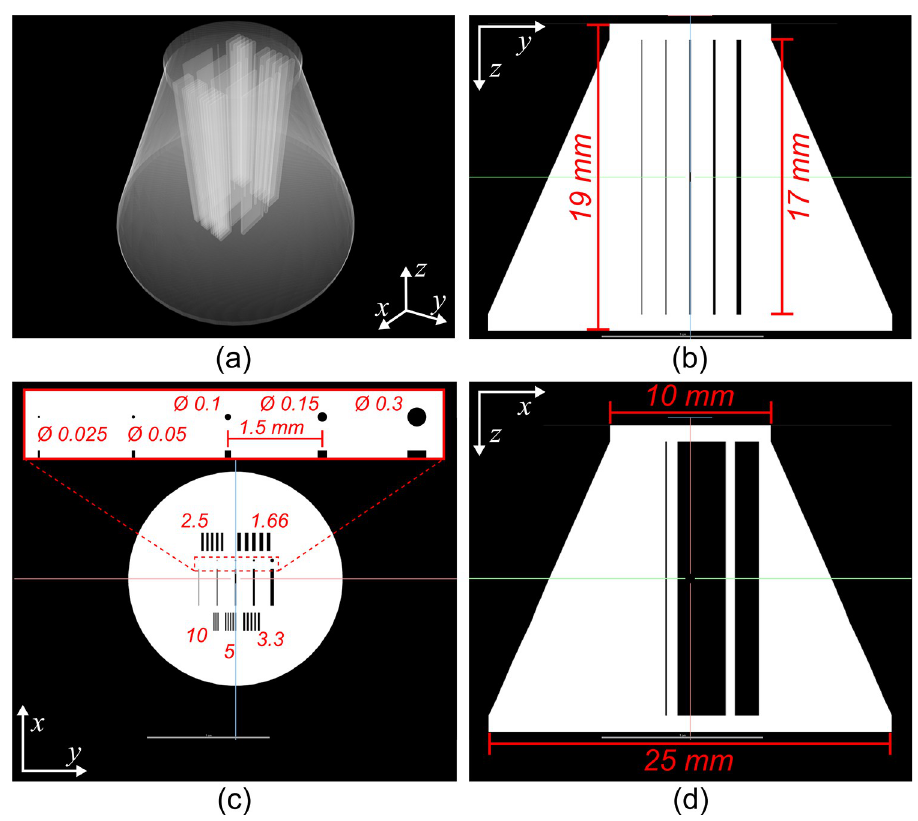
Fig 7. Computer-aided design (CAD) of the resolution titanium-alloy (Ti6Al4V) phantom. (a) translucent perspective view of 3D rendering of the phantom’s CAD. (b) Trans-coronal synthetic slice of the phantom’s CAD. (c) Trans-sagittal synthetic slice of the phantom’s CAD depicting details of the internal voids. The bar patterns are described in lp mm -1 all the other nominal measurements are shown in mm (d) Transaxial synthetic slice of the phantom’s CAD. Note that the labelled measurements represent the prescribed nominal values; these values may not be achieved during the manufacturing of the part.